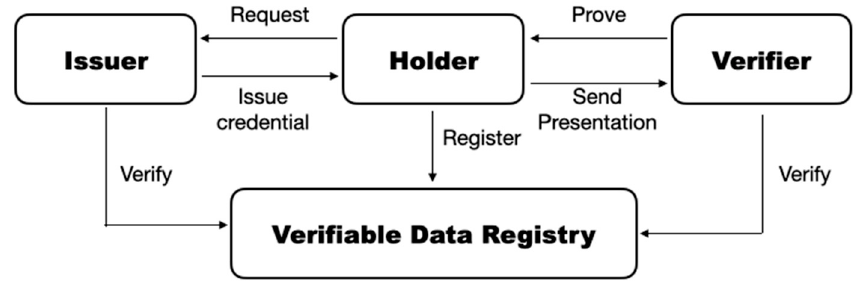
Figure 1. The DID model proposed by